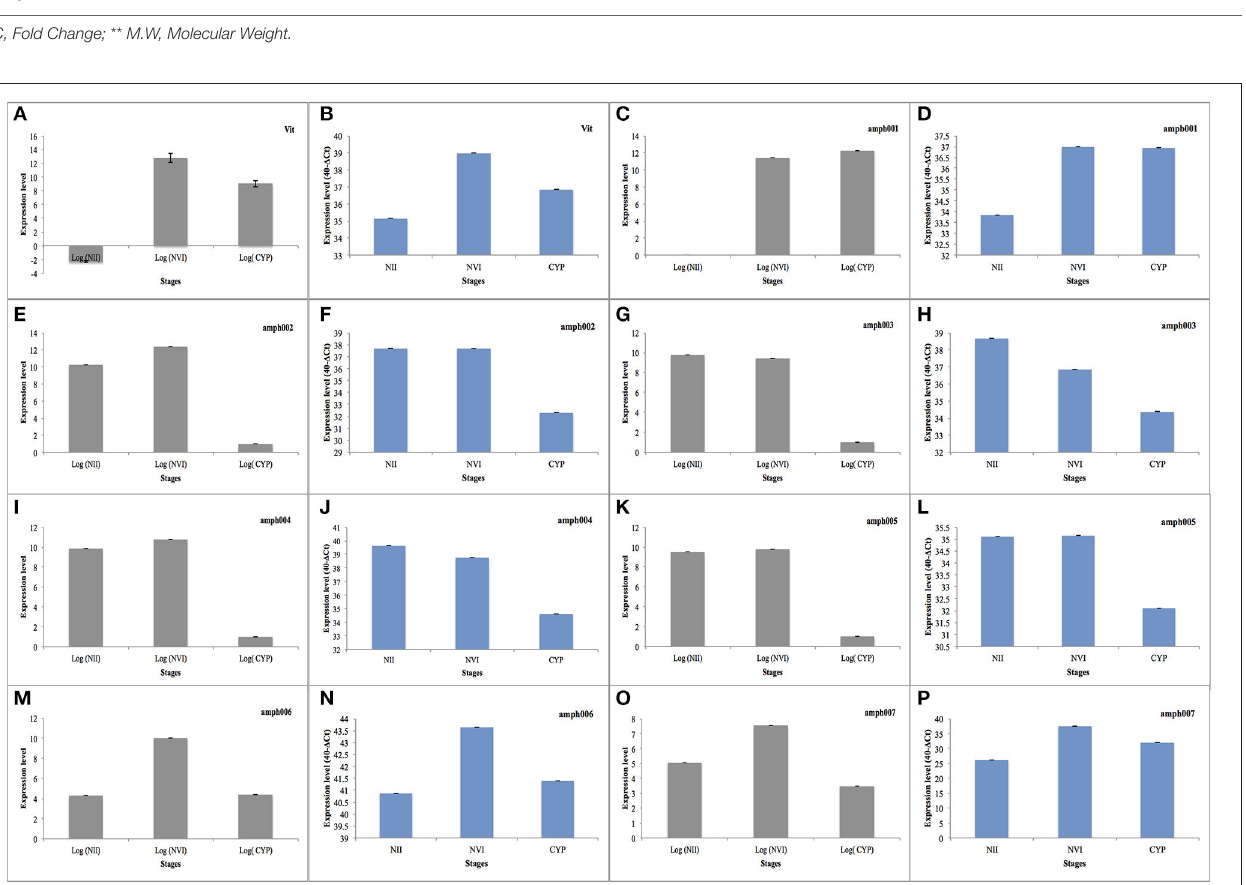
FIGURE 5 | Bar plot showing the expression level of mRNA of highly expressed genes (in Gray) and the expression level of the same genes determined by RT-qPCR (in Blue). (NII, nauplius II; NVI, napluis VI; CYP, Cyprid). (A,B) Up regulation of Vitellogenin between naplius VI compared to naplius II. (C,D) Up regulation of unknown between naplius VI compared to naplius II. (E–L) Down regulation during Cyprid stage compared to napulis VI in five unknown genes ampb002, ampb003, ampb004, and ampb005, respectively. (M–P) Different expression pattern between planktonic and sessile stage in ampb006 and